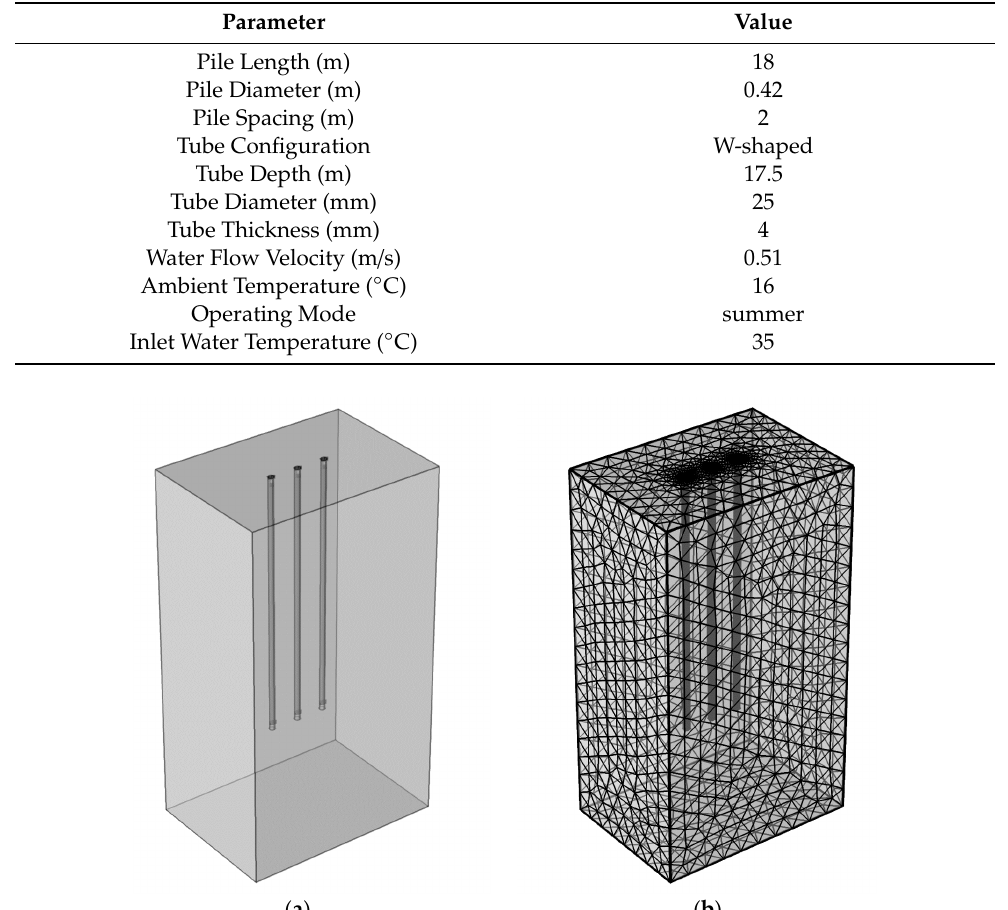
Table 4. Parameters of the energy pile of You et al.’s experiments [29]. Reprint with permission [4942921402906] from Energy and Buildings; published by Elsevier, Aug. 2014.